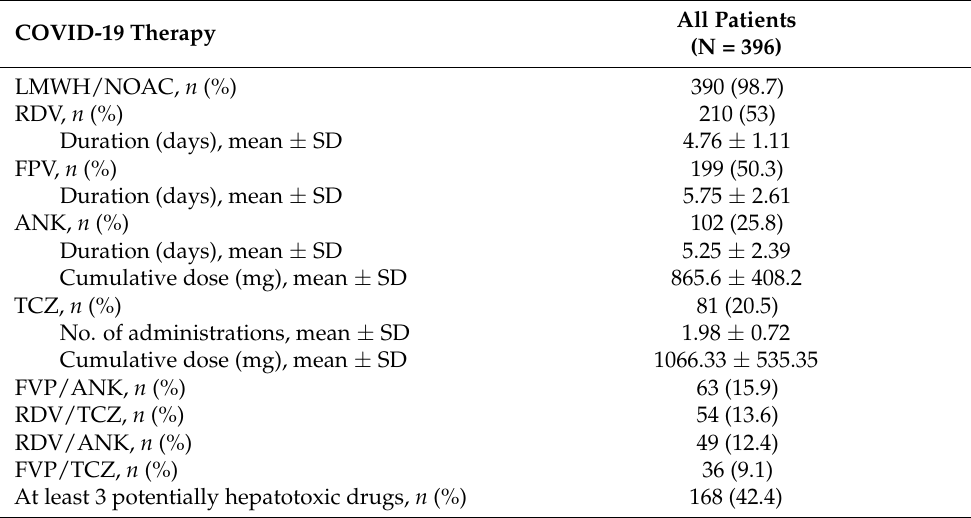
Table 2. COVID-19 therapy administered during